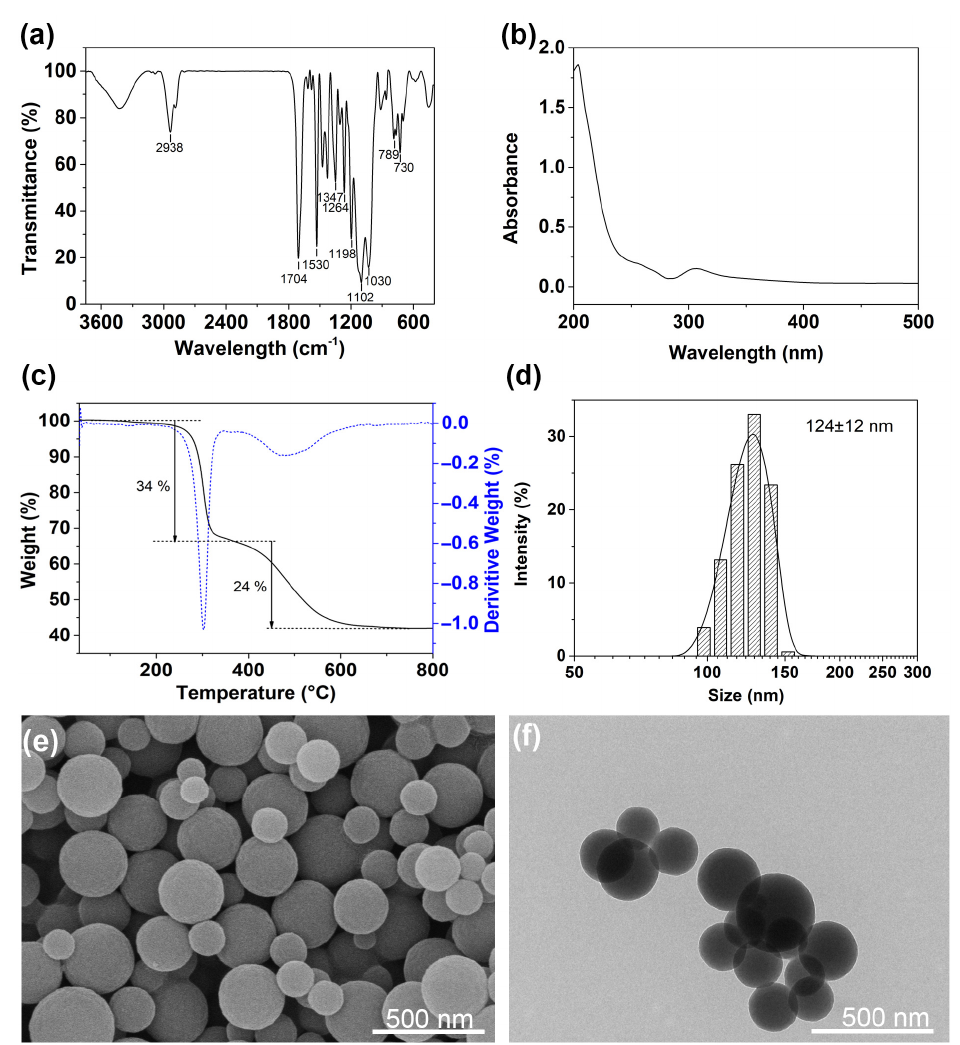
Figure 3. FTIR ( a ), UV–vis ( b ), TGA ( c ), and DLS ( d ) spectra of BPS. SEM ( e ) and TEM ( f ) micro- graphs of